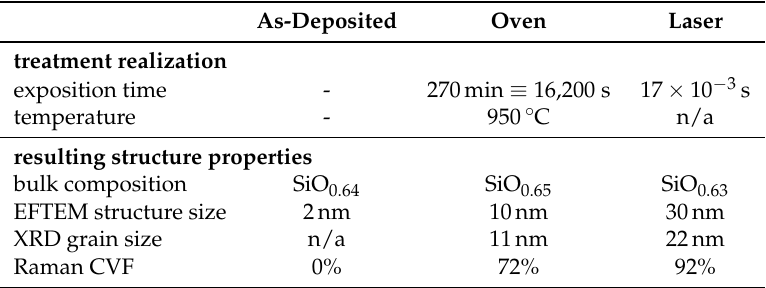
Table 2. Treatment parameters and selected structure properties of as-deposited, oven- or laser-treated SiO 0.6 layers. CVF, crystalline Si volume